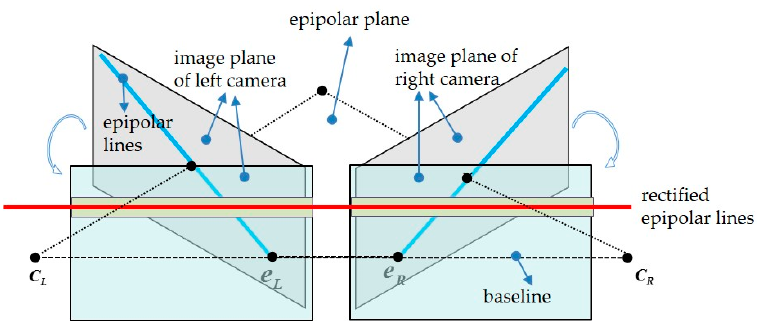
Figure 4. Schematic diagram of stereo rectification.